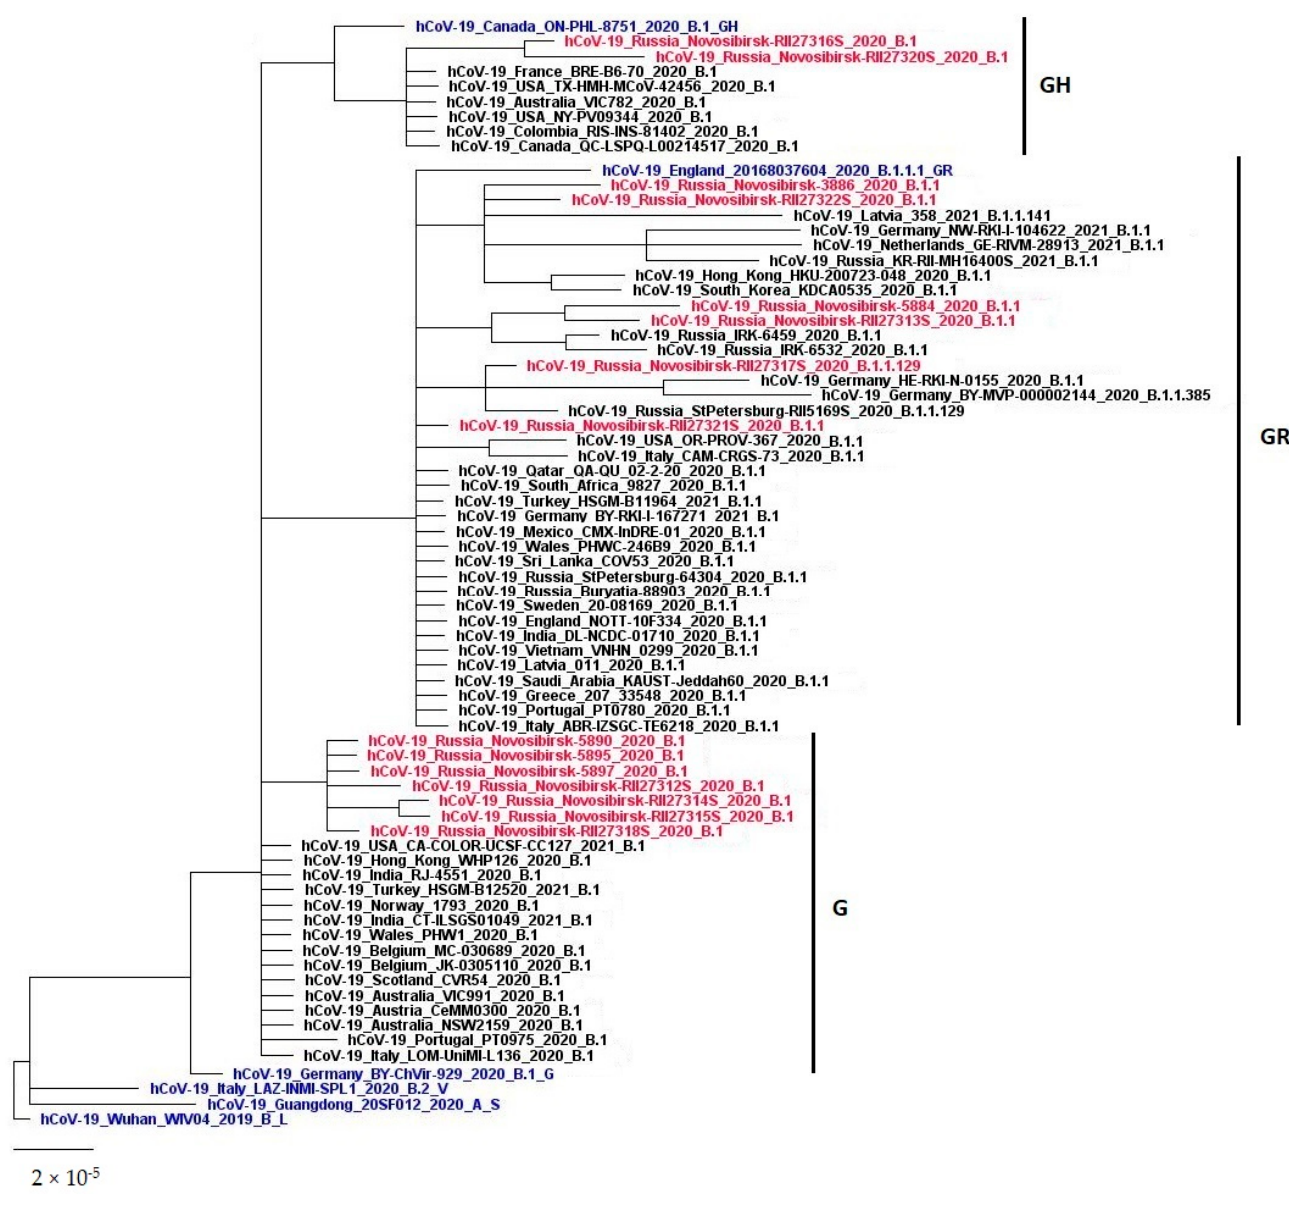
Figure 4. The phylogenetic dendrogram performed with MrBayes 3.2.7 and based on the whole genome nucleotide sequences of SARS-CoV-2. Red label—sequences of Novosibirsk isolates; blue label—reference sequences (according to GISAID EpiCoV).